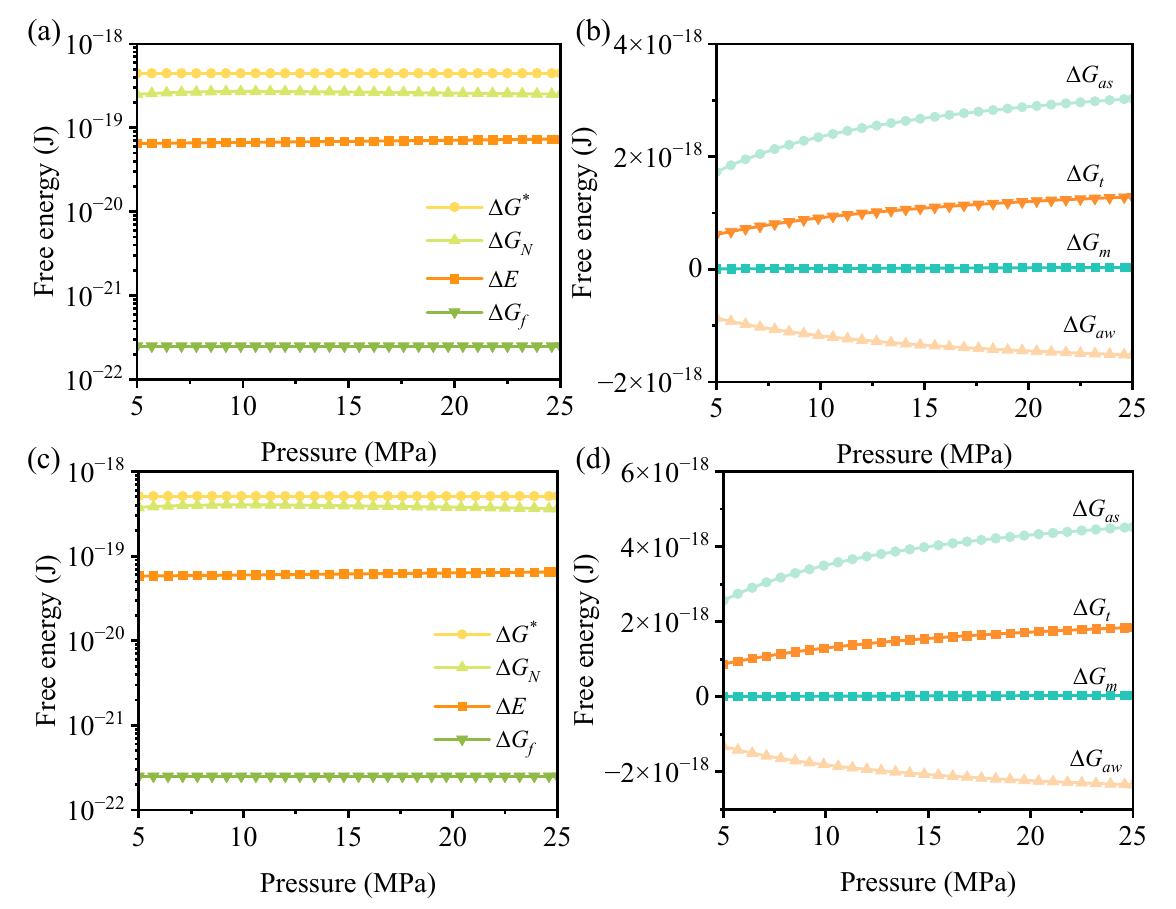
Figure 8. Dependence of ∆ G N , ∆ G f , ∆ E , ∆ G ∗ on N 2 pressure at ( a ) 130 ◦ C and ( c ) 140 ◦ C, variation of ∆ G as , ∆ G t , ∆ G m , ∆ G aw on N 2 pressure at ( b ) 130 ◦ C and ( d ) 140 ◦ C. Table 2. Detailed percentage of ∆ G as , ∆ G t , ∆ G m , ∆ G aw under different